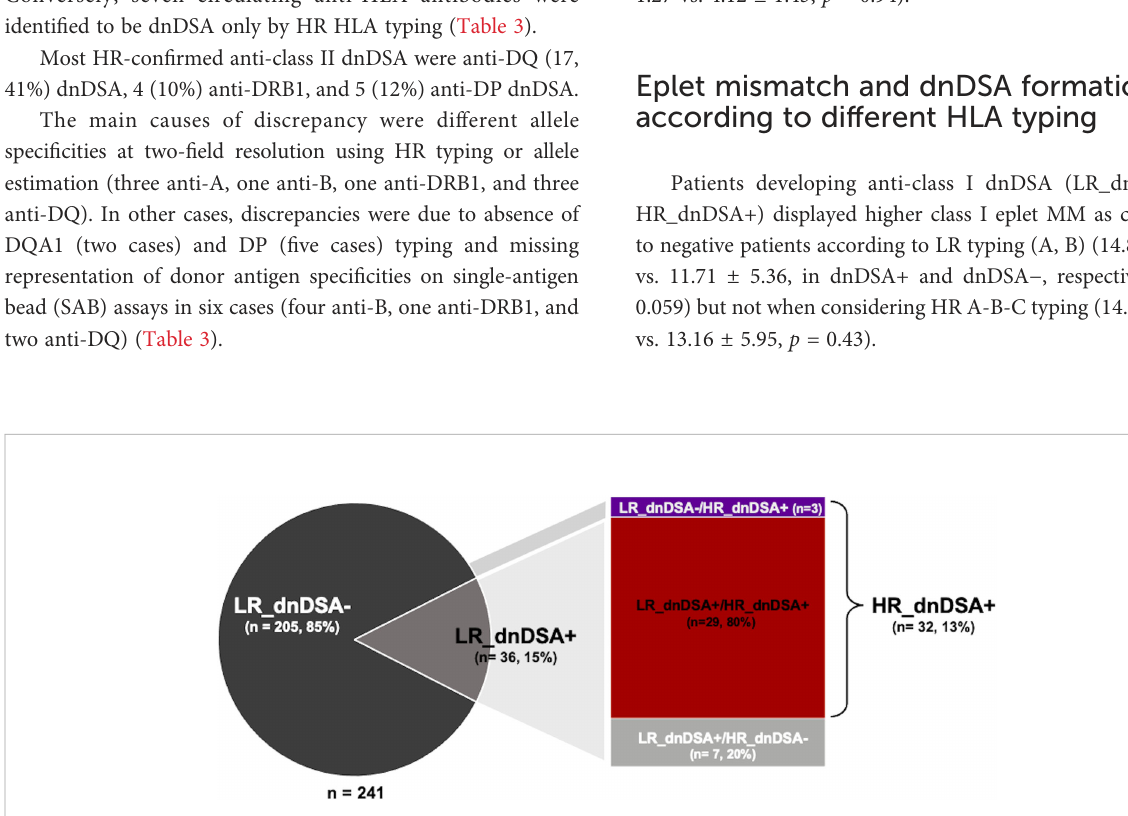
FIGURE 3 Proportion of patients with dnDSA according to LR or complete HR HLA typing. dnDSA, de novo donor -speci fi c antibody; HR, high resolution; LR, low